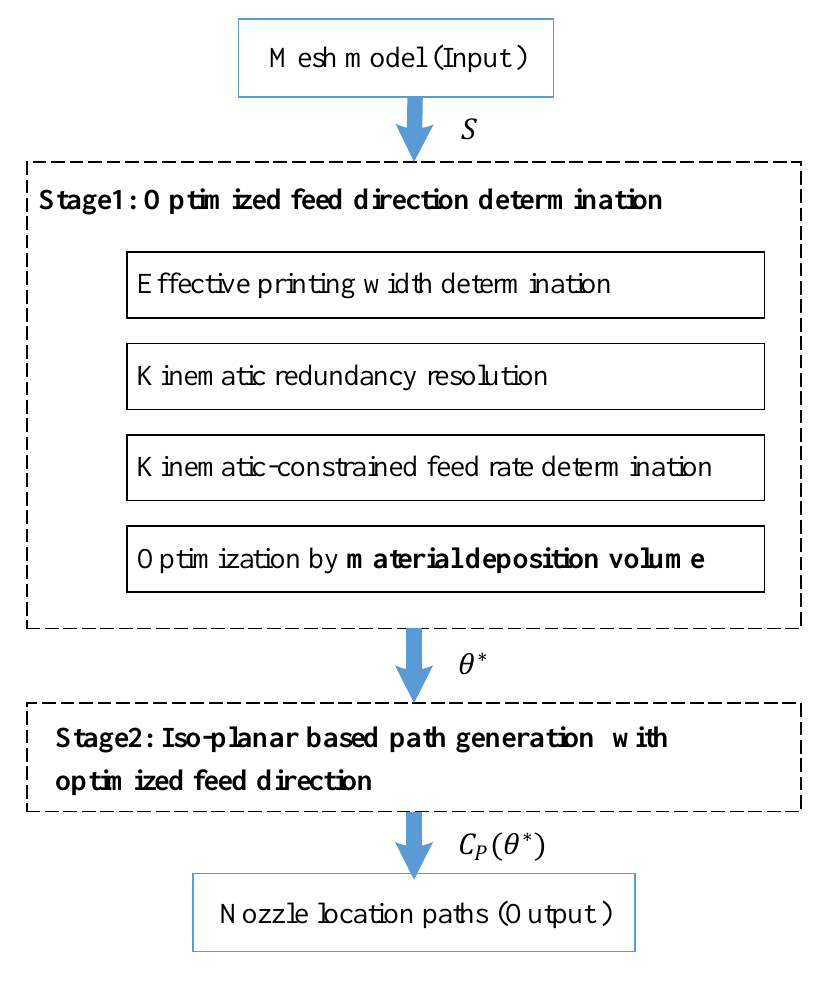
Figure 1. Flow chart of the proposed method.